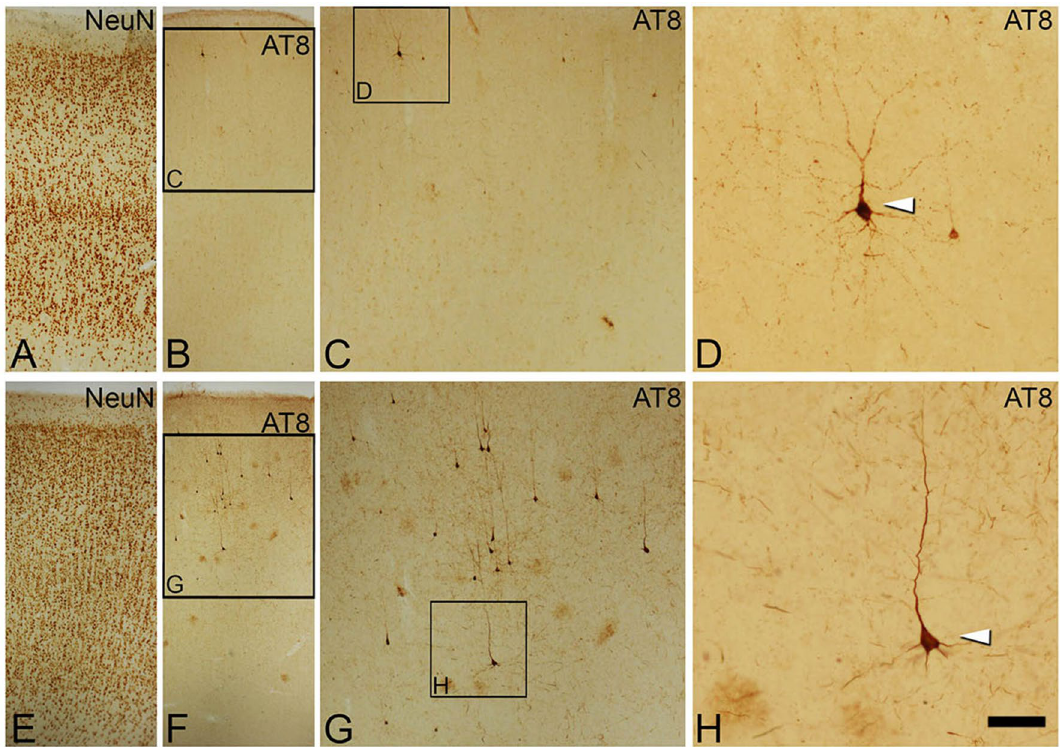
Figure 1. Photomicrographs taken from brain sections of the temporal neocortex from an AD patient (IF8, A − D ) and a non-demented human case (AB1, E − H ), showing the distribution of neurons with hyperphosphorylated tau revealed by DAB immunostaining with AT8 antibodies ( B and F ) in different cortical layers identified by NeuN immunostaining of adjacent sections ( A and E , respectively).Squared areas in B, C, F and G are shown at higher magnification in C, D, G and H, respectively. Arrowheads indicate AT8-positive neurons. Scale bar shown in H indicates 106 µm in A, B, E and F, 47 µm in C and G and 21 µm in D and H. Adobe Photoshop CS4 software was used to compose